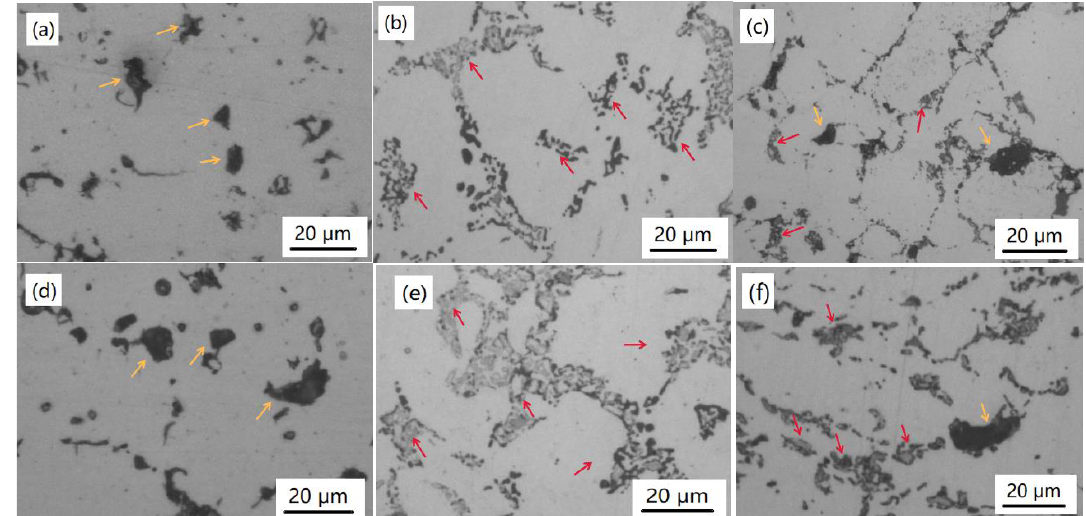
Figure 2. Microstructures of the IMCs supplemented with ( a ) 15% SiC, ( b ) 15% Ti 3 AlC 2 , ( c ) 15% (SiC + Ti 3 AlC 2 ), ( d ) 20% SiC, ( e ) 20% Ti 3 AlC 2 , and ( f ) 20% (SiC + Ti 3 AlC 2 ). SiC is indicated by the yellow arrow and TiC x is indicated by the red arrow.